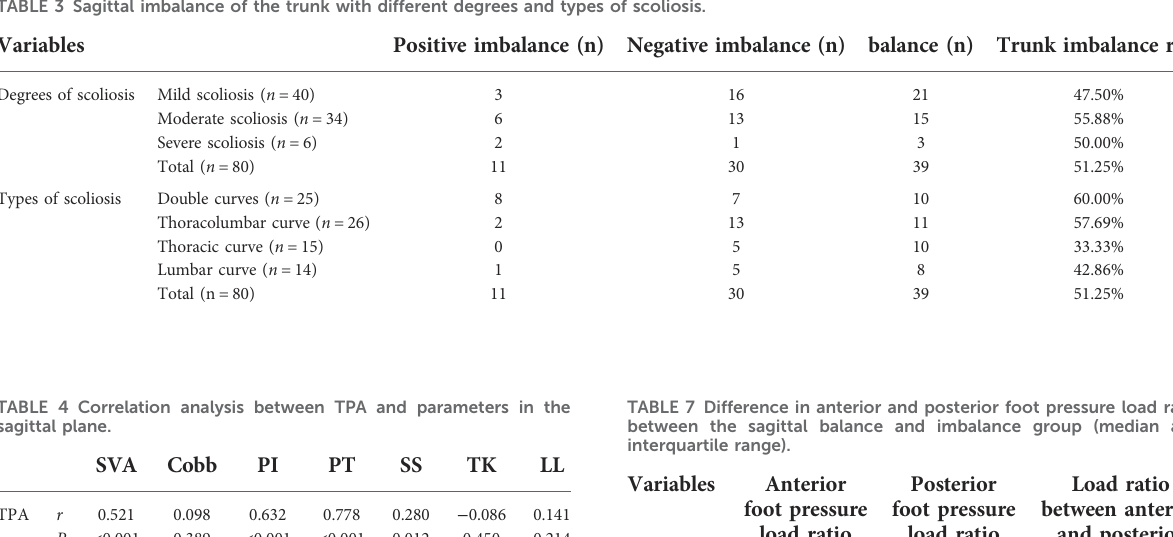
TABLE 3 Sagittal imbalance of the trunk with different degrees and types of scoliosis.